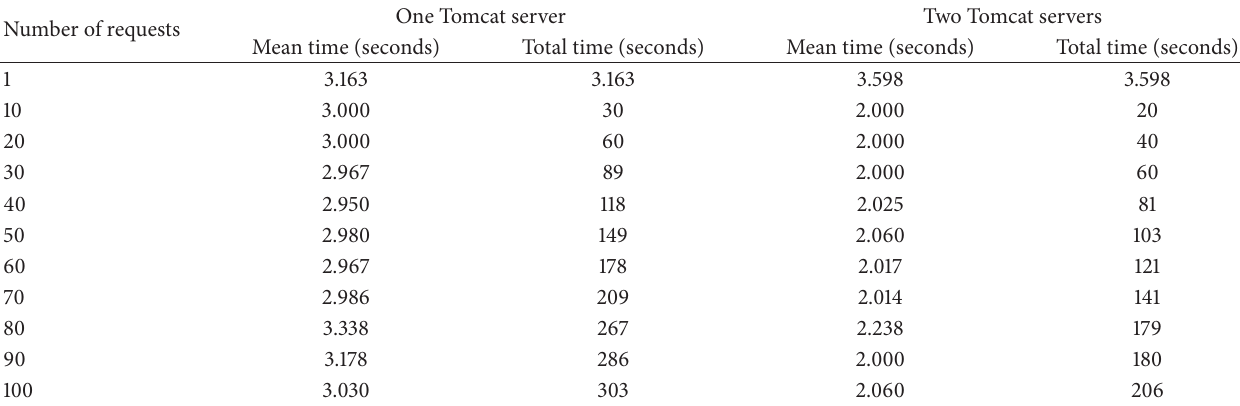
Table 3: Times required to submit different numbers of requests within 1 second when using an RSA cipher.